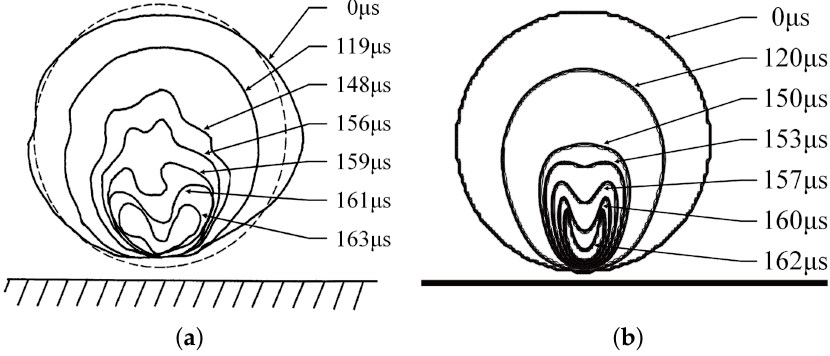
Figure 3. ( a ) Schematic showing the configuration of a bubble near a wall; ( b ) collapse time for the cases in Table 1.